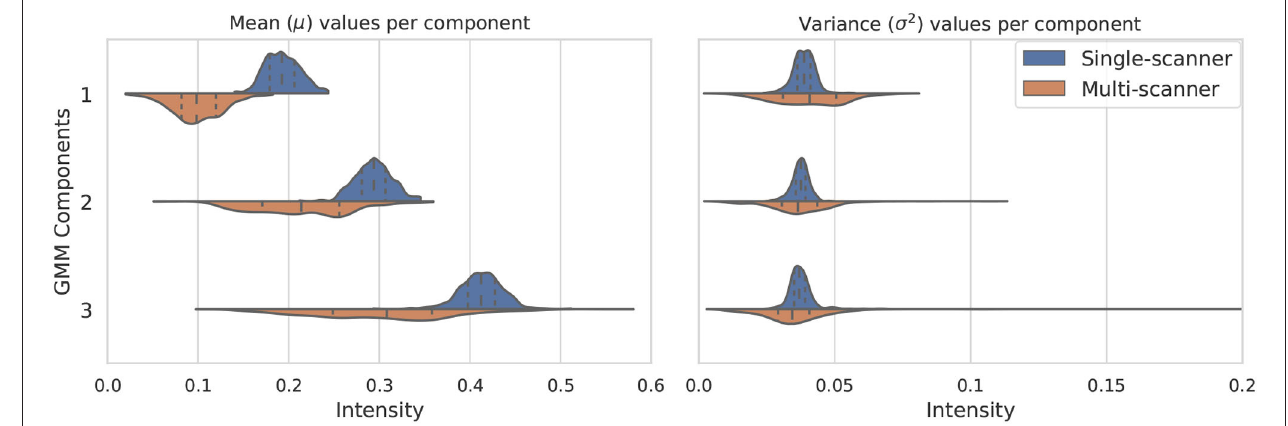
FIGURE 2 | Variation of the three considered GMM components in terms of mean µ k (left) and variance σ 2 k (right). The components vary much more in a multi-scanner dataset than in a single-scanner